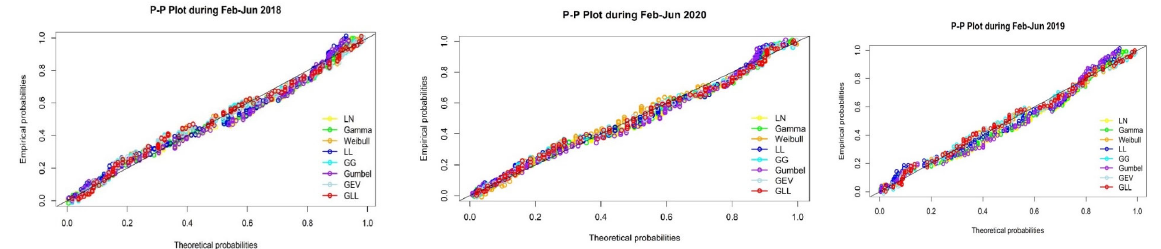
Fig. 6 . The probability–probability (P–P) plot of the LN, gamma, Weibull, LL, Gumbel, GG, GEV, and GLL distributions of PM 2.5 concentrations in the period without and during the period with